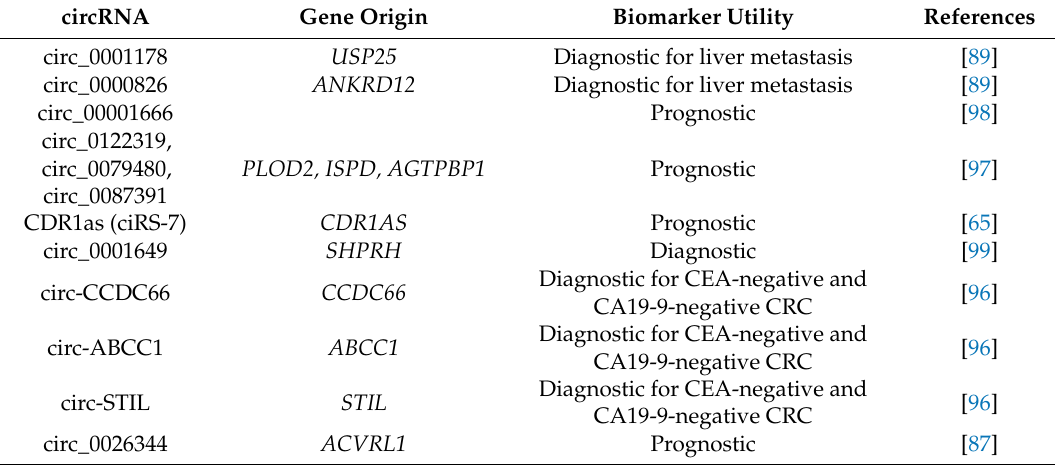
Table 3. circRNAs as potential prognostic or diagnostic biomarkers in